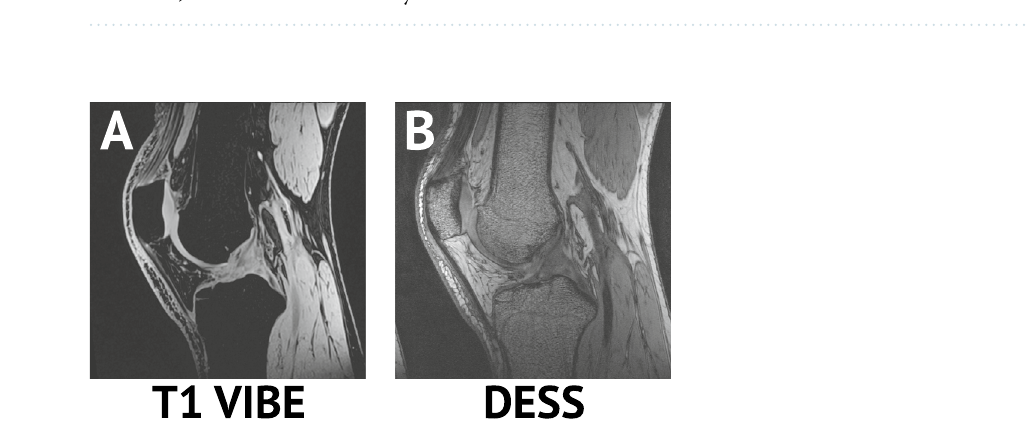
Table 1. MRI parameters. T1 VIBE T1-weighted volume-interpolated breathhold examination with water excitation, DESS double echo steady-state.